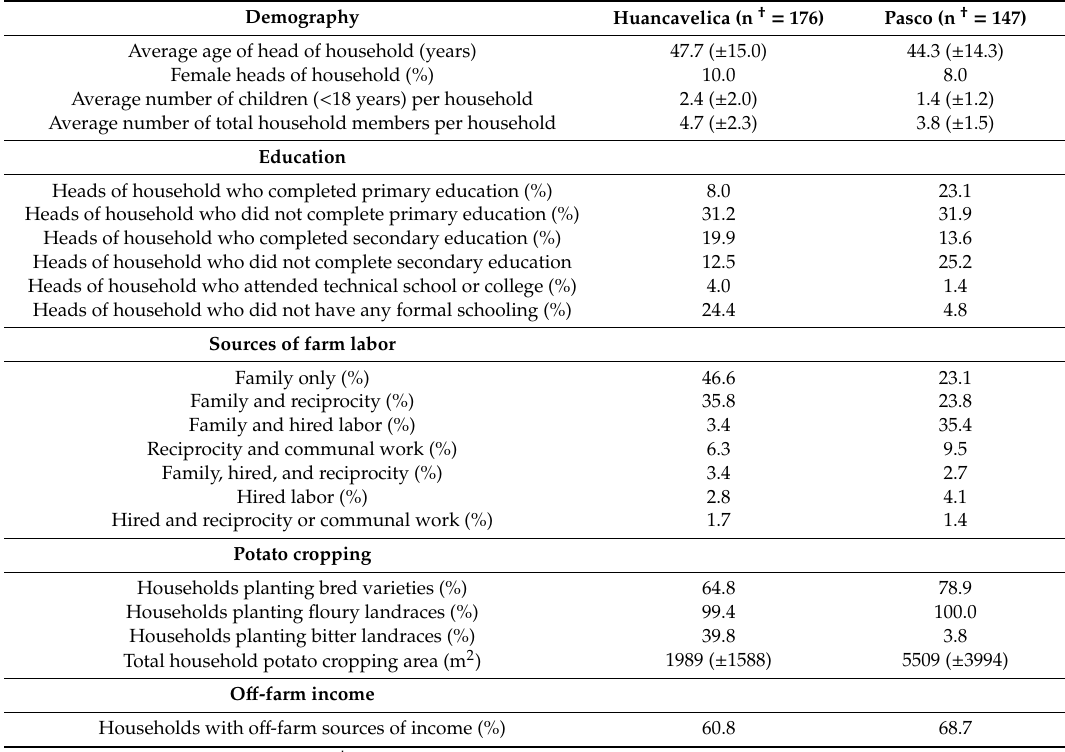
Table 3. Main household-level characteristics by